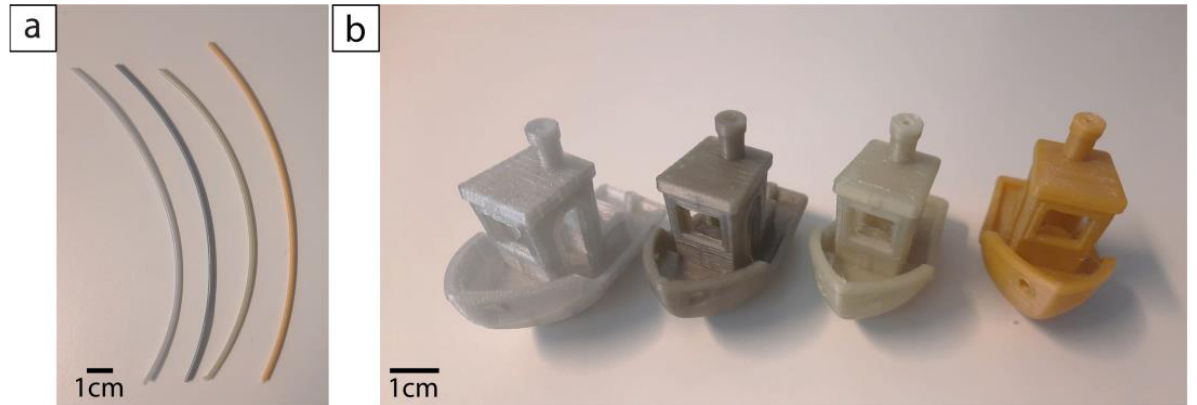
Figure 2. Filaments E-PET0, E-PET2, E-PET5, and E-PET10, from left to right ( a ), and 3D benchy models printed with recycled PET contaminated with 0%, 2%, 5%, and 10% HDPE, from left to right ( b ).